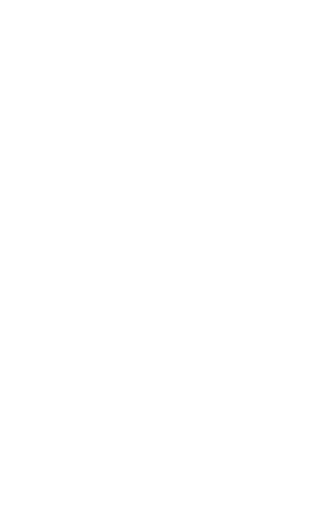
Figure 1. Environment of